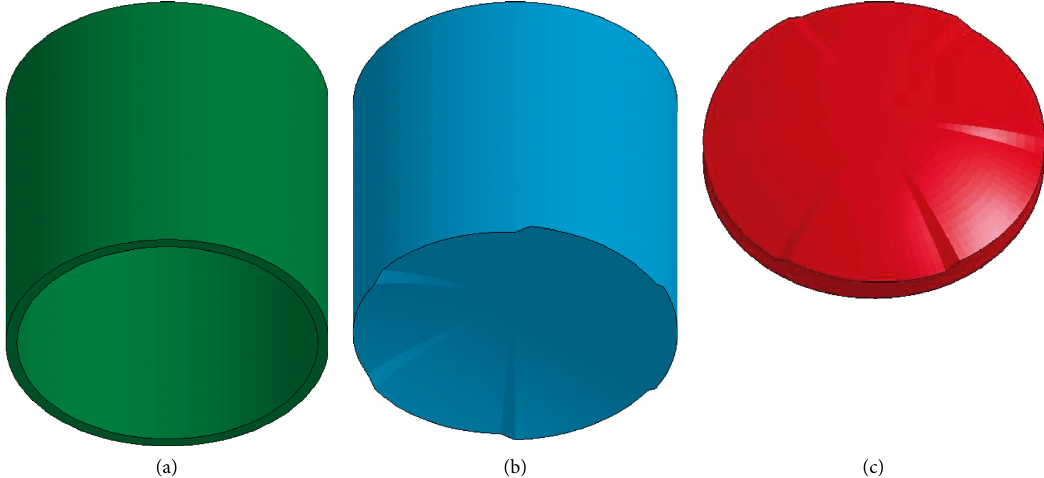
Figure 12: Finite element model of an EFP-shaped charge: (a) shell, (b) charge, and (c)